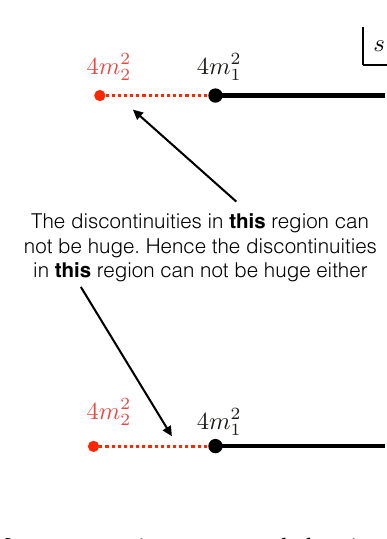
11 = M 11 22 contains an extended unitarity ! ! 11 . That, in turn, can not be too !